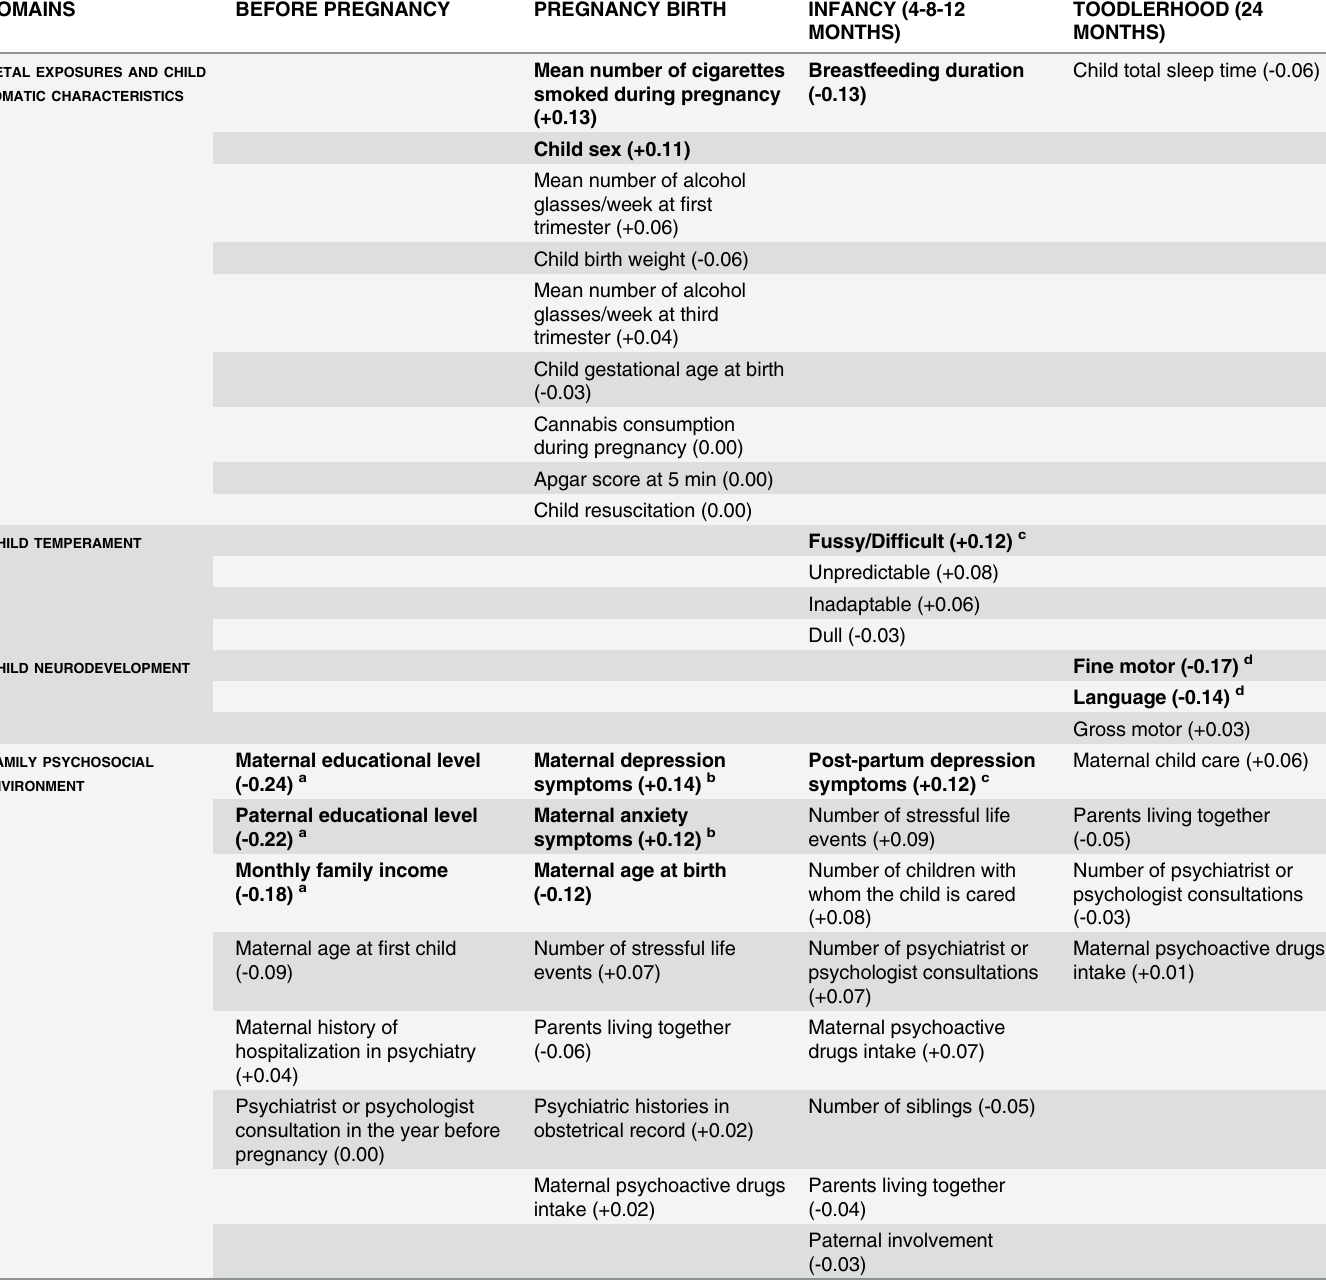
Table 1. Potential risk factors for inattention-hyperactivity symptoms at 3